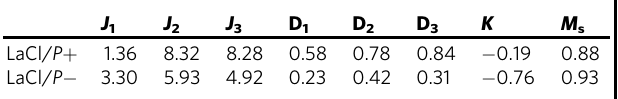
Table 1 Magnetic parameters of LaCl/In 2 Se 3